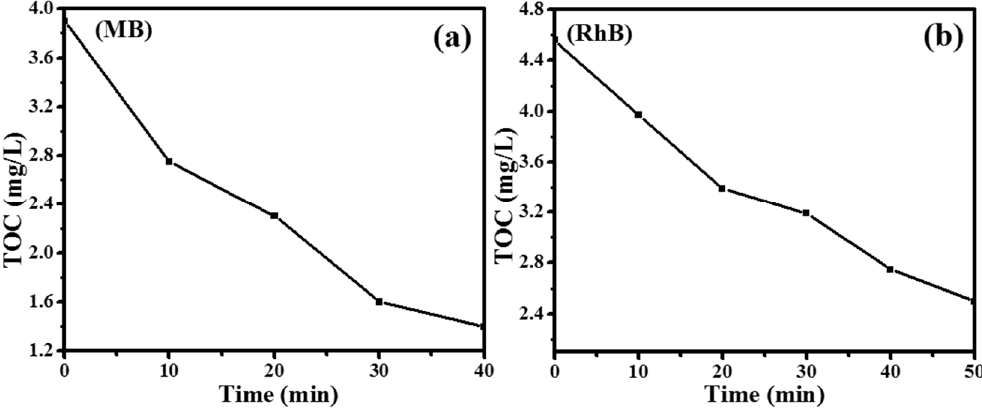
Figure 8. Changes in total organic carbon (TOC) during photodegradation of ( a ) MB and ( b ) RhB with SAP/PAN.